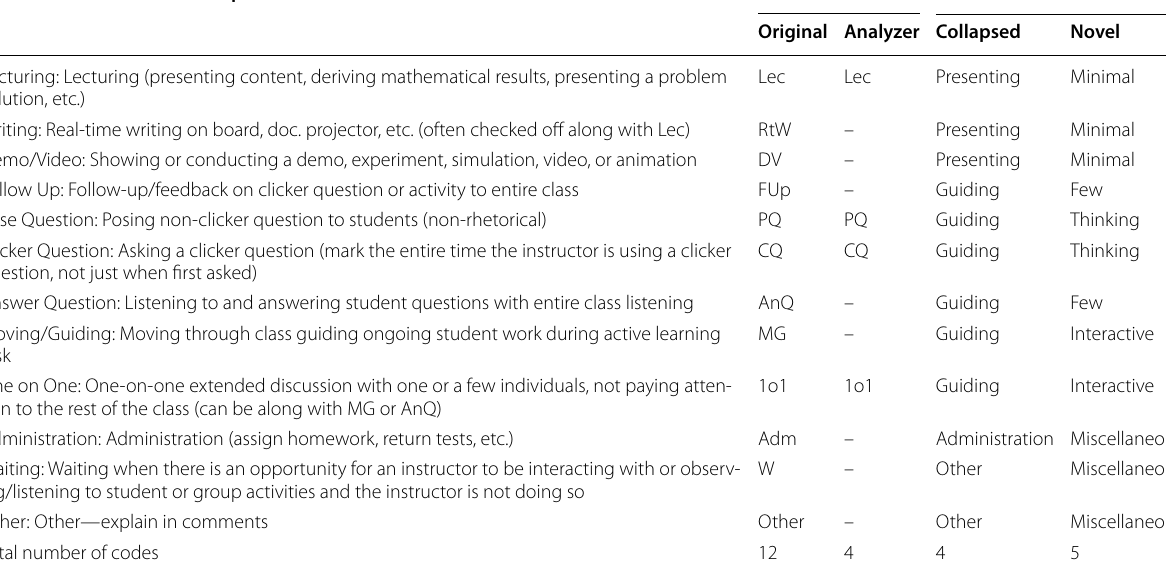
Table 2 Instructor COPUS codes Instructor COPUS code